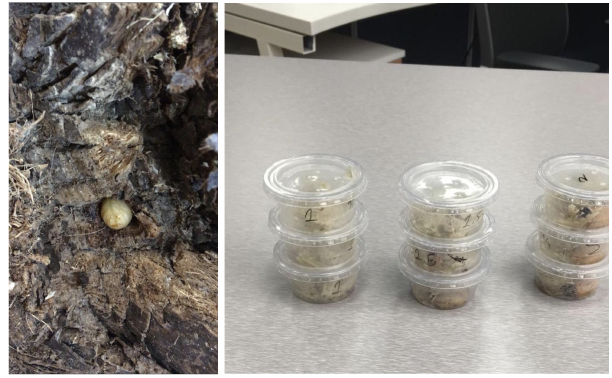
Figure 8. Larvae used in